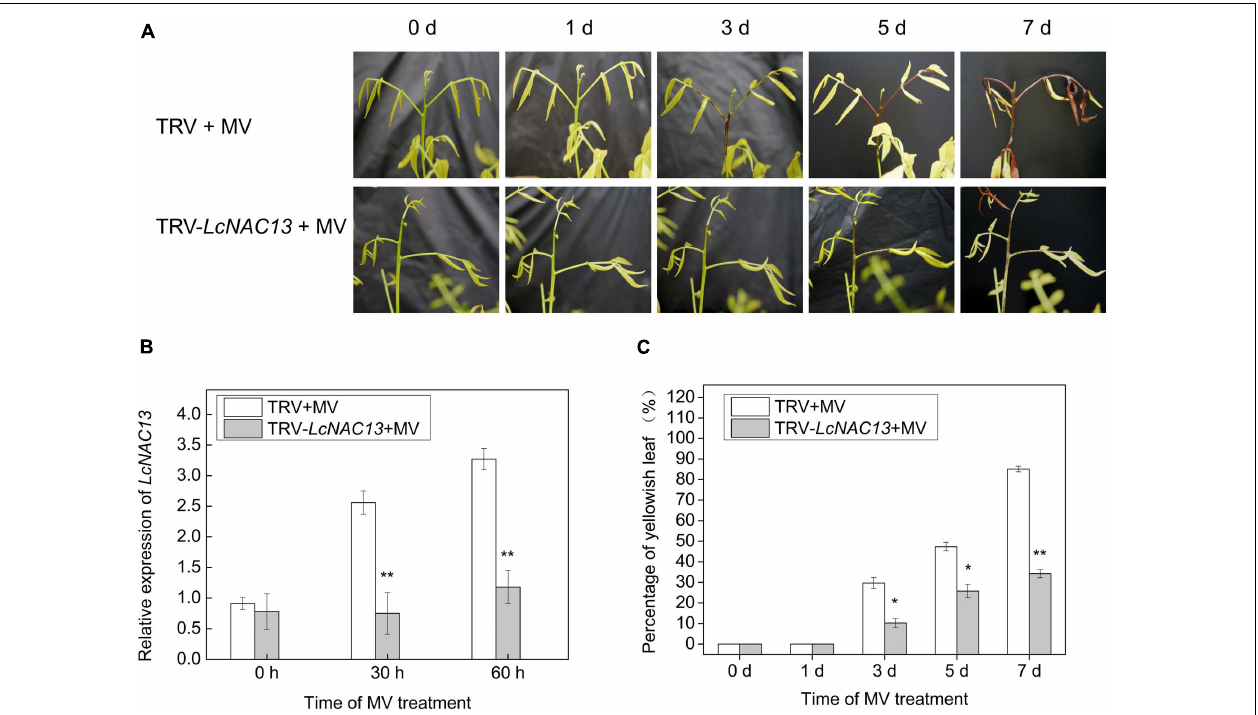
FIGURE 7 | LcNAC13 silencing delays MV-induced senescence in litchi leaves. (A) Phenotype of the virus-induced gene silencing- (VIGS) treated and control leaves after MV-generated ROS treatment. TRV + MV represents control, and TRV– LcNAC5 + MV represents VIGS treatment. (B) LcNAC13 expression level of the VIGS-treated and control leaves after MV treatment. (C) Percentage of the yellowish leaves. Data are means of three replicates, and the bars represent SEs. Significant differences according to the Student’s t -test between VIGS-treated and control leaves at the same time point are indicated by the asterisks (* P < 0.05, ** P < 0.01).